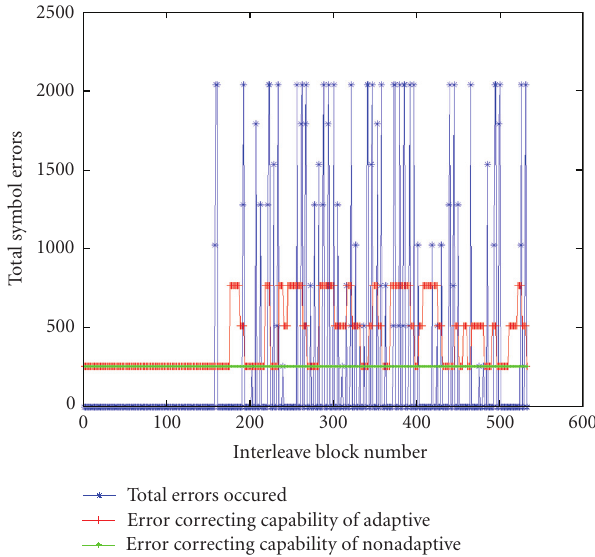
Figure 8: Performance of prediction for “ all” sequence at 32kbps, random delay 0.026, bu ff er size 500, packet size 256, span 16, PL rate 4.9%.